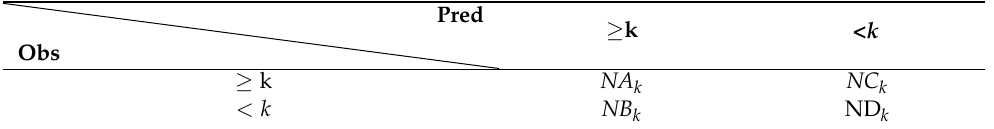
Table 1. The validation of the radar echo predictions at different reflectivity